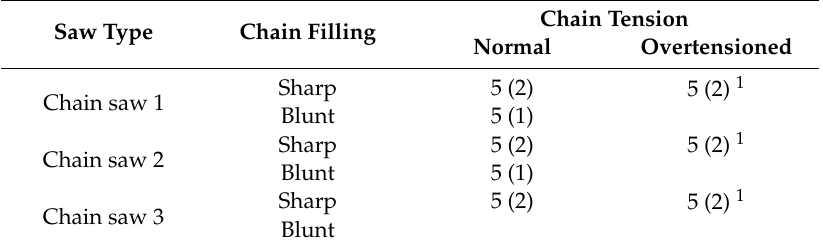
Table 2. Trial setup and number of replications per factorial